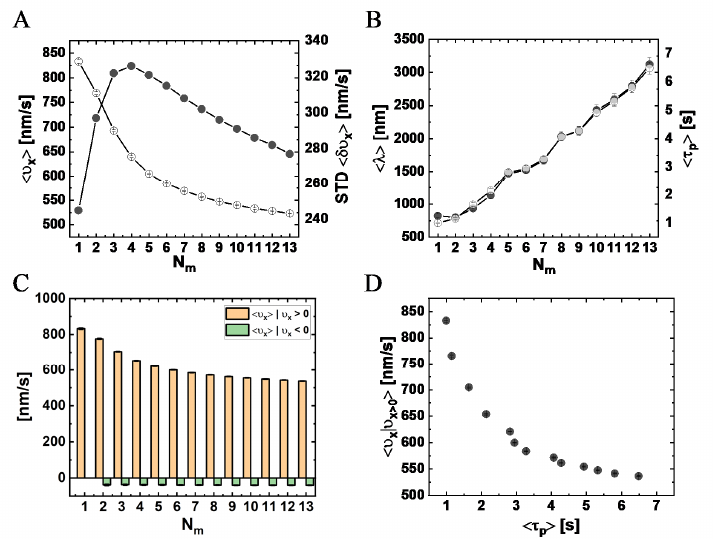
Figure 7. Simulation results for the mean longitudinal velocity, (cid:104) υ x (cid:105) , run-length, (cid:104) λ (cid:105) , and run-time, (cid:104) τ p (cid:105) for different ( R = 20 nm, N m ) configurations, for a time interval ∆ t = 0.27 s. ( A ) The data for the mean ( ± SEM ) longitudinal velocity (black dots) and STD (empty circles) are provided in Table S5 see Figure S11 and Table S9 for a ∆ t = MC step time. ( B ) Mean ( ± SEM ) run-length (black dots) and run-time (empty circles), using the data provided in Table S10. ( C ) Mean ( ± SEM ) instantaneous longitudinal velocity, (cid:104) υ x (cid:105) , separated for minus-end directed, υ x > 0, and plus-end directed, υ x < 0, directions; data are provided in Table S6. ( D ) Mean ( ± SEM ) instantaneous minus-end directed longitudinal velocity (cid:104) υ x (cid:105) | υ x > 0 against mean run-time (cid:104) τ p (cid:105)